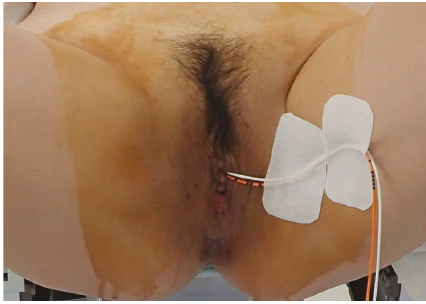
Figure 2: Fixation of the ureteral catheters to the thigh with tape. In this case, the left and right sides of the ureter where the catheter was inserted were discriminated by color. The white catheter was inserted into the right ureter, and the orange one was inserted into the left